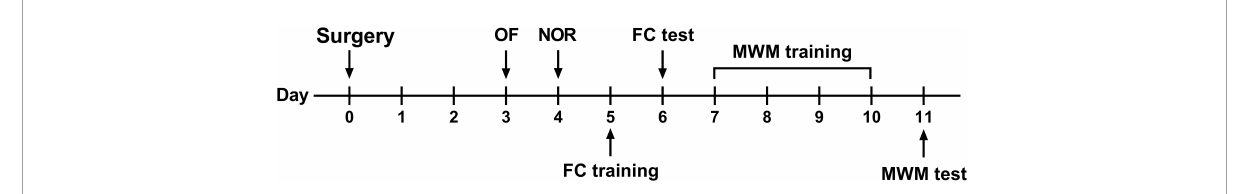
FIGURE1 Behavioral experimental flow. OF, open field test; NOR, novel object recognition test; FC, fear conditioning; MWM, Morris water maze.